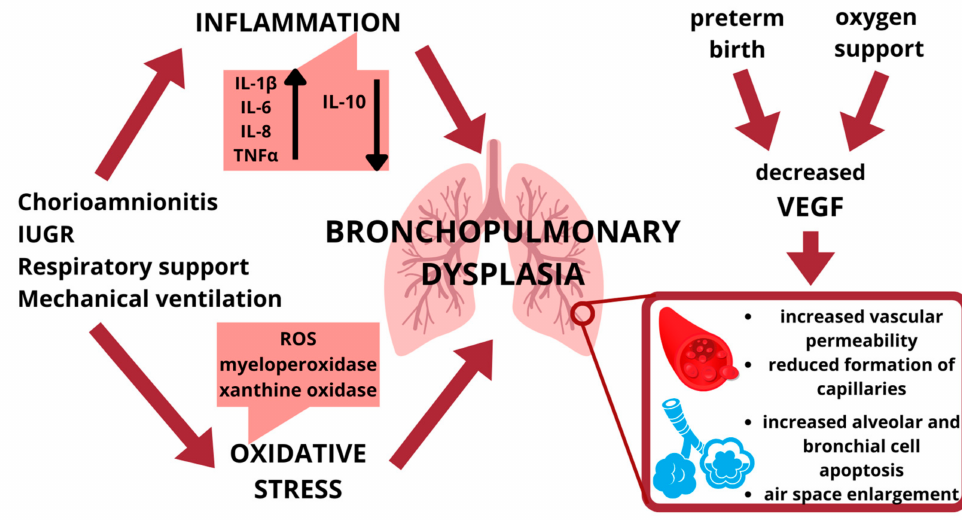
Figure 1. Schematic representation of risk factors associated with bronchopulmonary